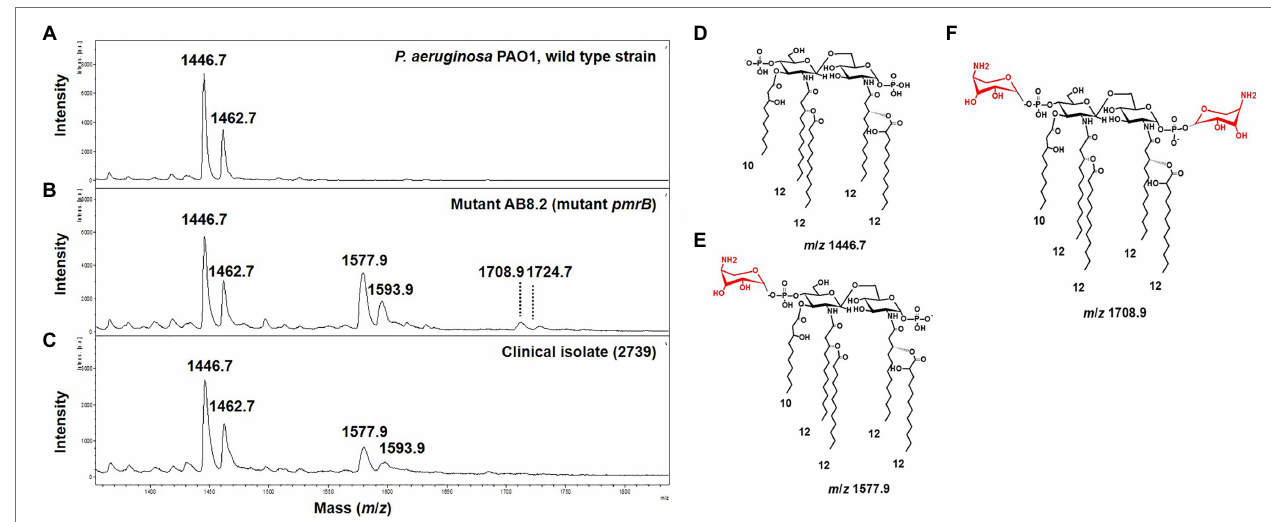
FIGURE 1 | Representative mass spectra of susceptible and modified Pseudomonas aeruginosa lipid A acquired using the linear negative-ion mode of a matrix- assisted laser desorption ionization (MALDI) Biotyper Sirius system (Bruker Daltonics). (A) Susceptible P. aeruginosa PAO1 lipid A is detected as two major peaks at m / z 1,446.7 and m / z 1,462.7. (B) Lipid A from mutant pmrB (AB8.2) with additional peaks at m / z 1,577.9, m / z 1,593.9, m / z 1,708.9, and m / z 1,724.9 corresponding to 4-amino- L -arabinose ( L -Ara4N) addition on the penta-acylated lipid A (peaks at m/z m/z 1,446.7 and m / z 1,462.7). (C) Lipid A from colistin- resistant P. aeruginosa clinical isolates is modified by L -Ara4N, which are detected as additional peaks at m / z 1,577.9, m / z 1,593.9. (D) Diagram of P. aeruginosa lipid A at m / z 1,446.7. (E) Diagram of P. aeruginosa lipid A at m / z 1,577.9. L -Ara4N residue is shown in red. (F) Diagram of P. aeruginosa lipid A at m / z 1,708.9. L -Ara4N residues are shown in